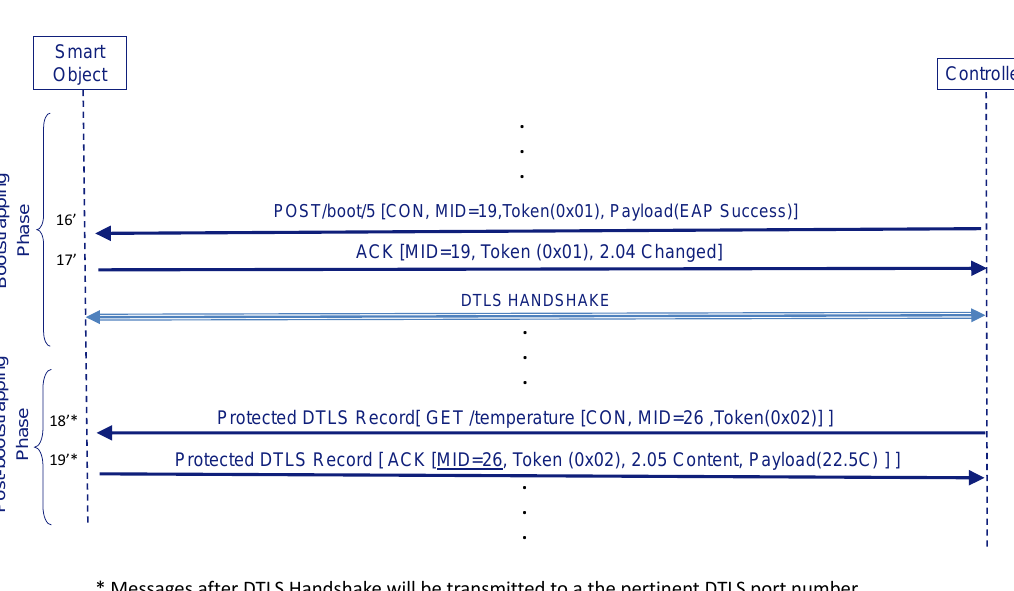
Figure 6. Protecting post-boostrapping with datagram transport layer security